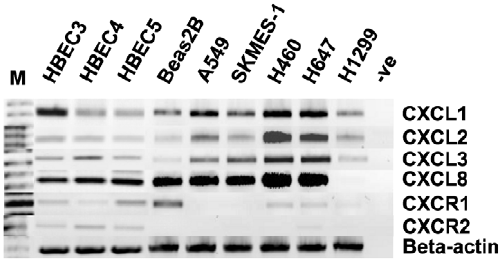
Figure 2. Expression of CXCL1 – 3 , CXCL8 and CXCR1/2 in a panel of normal and NSCLC cancer cell lines. The panel included A549 (adenocarcinoma), SKMES-1 (squamous cell carcinoma), H460, H647 and H1299 (large cell carcinoma), BEAS-2B (SV40 transformed normal bronchoepithelial) and HBEC cell lines (normal bronchial epithelial cell lines immortalised in the absence of viral oncoproteins). Beta actin is included to validate loading efficiency. (M – DNA size marker, -ve – Negative RT-PCR